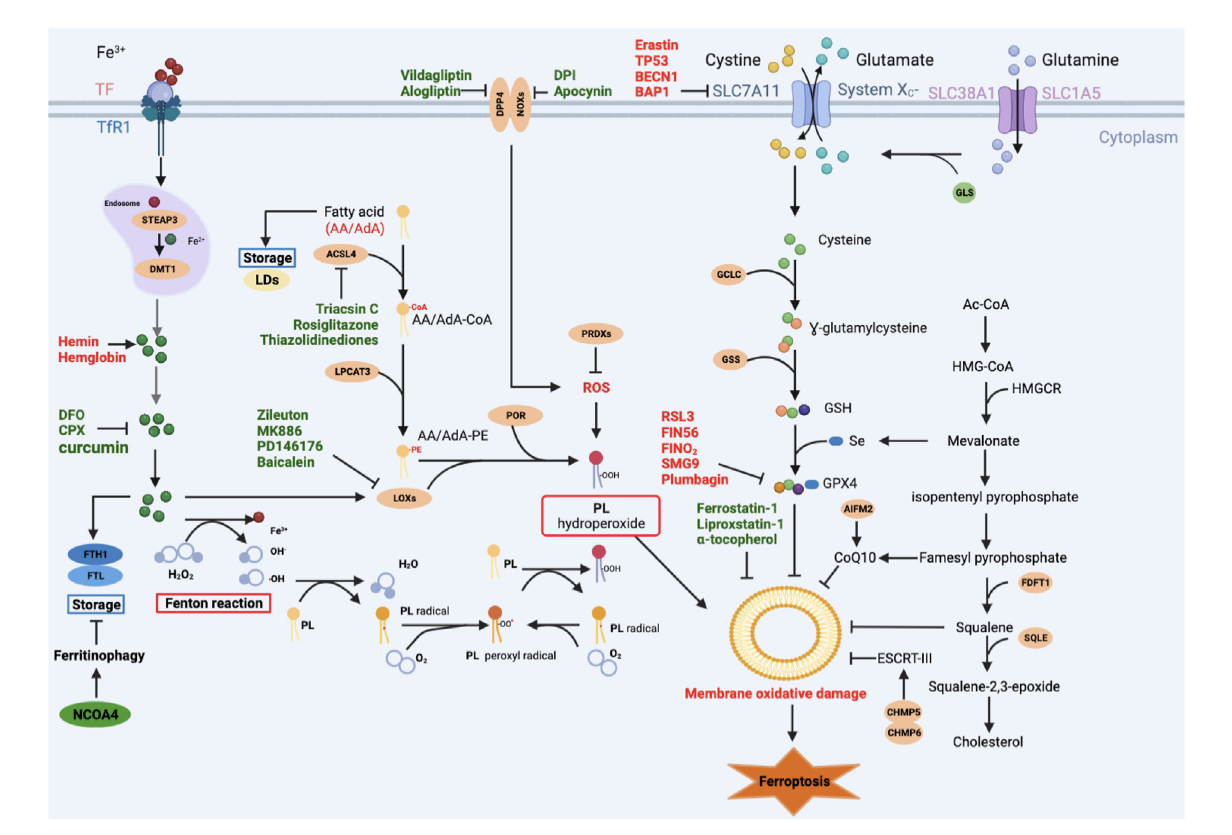
FIGURE 1 Main signaling pathways of ferroptosis. Ferroptosis can occur through three major pathways: 1) Iron overload: Fe 2+ may directly generate excessive lipid reactive oxygen species (ROS) through the Fenton reaction, or Fe 2+ acts as a cofactor of lipoxygenase (LOX) or prolyl hydroxylase, leading to lipid peroxidationandoxygenhomeostasis.2)Lipidperoxidation:ACSL4catalyzestheligationofCoAintofreeAA/AdAtoformAA/AdA-CoA.AA/AdA-CoAare esteri fi edintoPEbyLPCAT3to formAA/AdA-PE.PE-AA/AdA-OOHareproducedbytheperoxidationoftheAA/AdA-PE throughnon-enzymatically autoxidation (Fenton reaction) or enzyme-mediated pathways (LOXs). 3) Antioxidant systems: the SLC7A11-GSH-GPX4 axis, CoQ10 system, and other antioxidants like AIFM2, squalene. Red-colored: ferroptosis inducers; Green-colored: ferroptosis